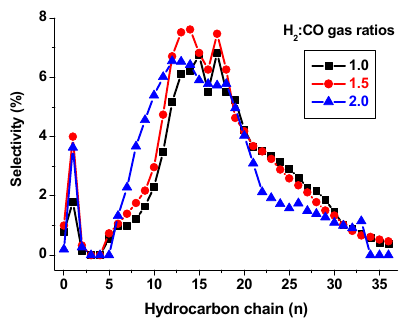
Figure 6. Effect of gas composition on the product spectrum of Fischer ‐ Tropsch synthesis (FTS) after 24 h on stream at 220 °C, 2 MPa and gas hourly space velocity (GHSV) of 3600 cm 3 ∙ g − 1 ∙ h − 1 . Figure 8. Effect of gas composition on the product spectrum of Fischer-Tropsch synthesis (FTS) after 24 h on stream at 220 ◦ C, 2 MPa and gas hourly space velocity (GHSV) of 3600 cm 3 · g − 1 · h − 1 .